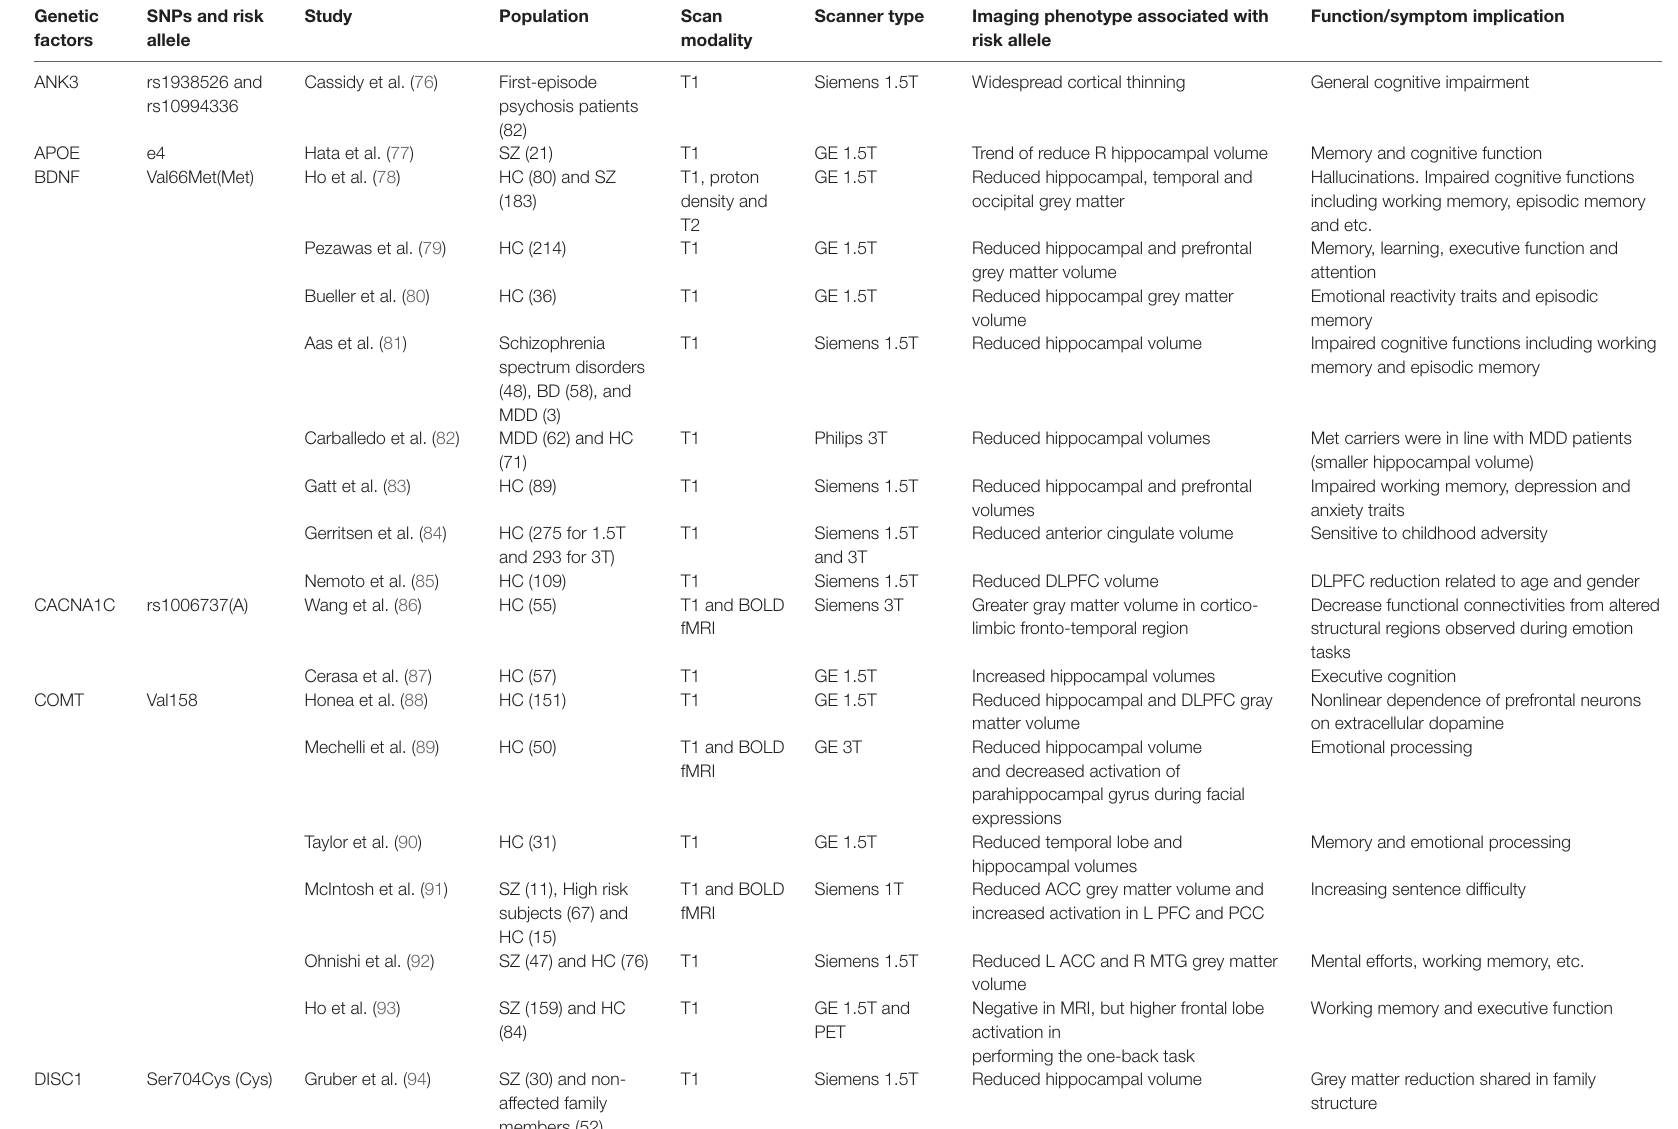
TABLE 2 | Potential structural imaging genetic phenotypes and possible function association. Genetic